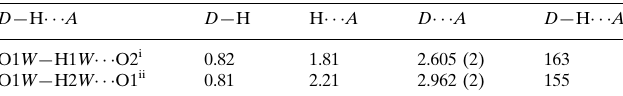
Hydrogen-bond geometry (A˚ , (cid:2)